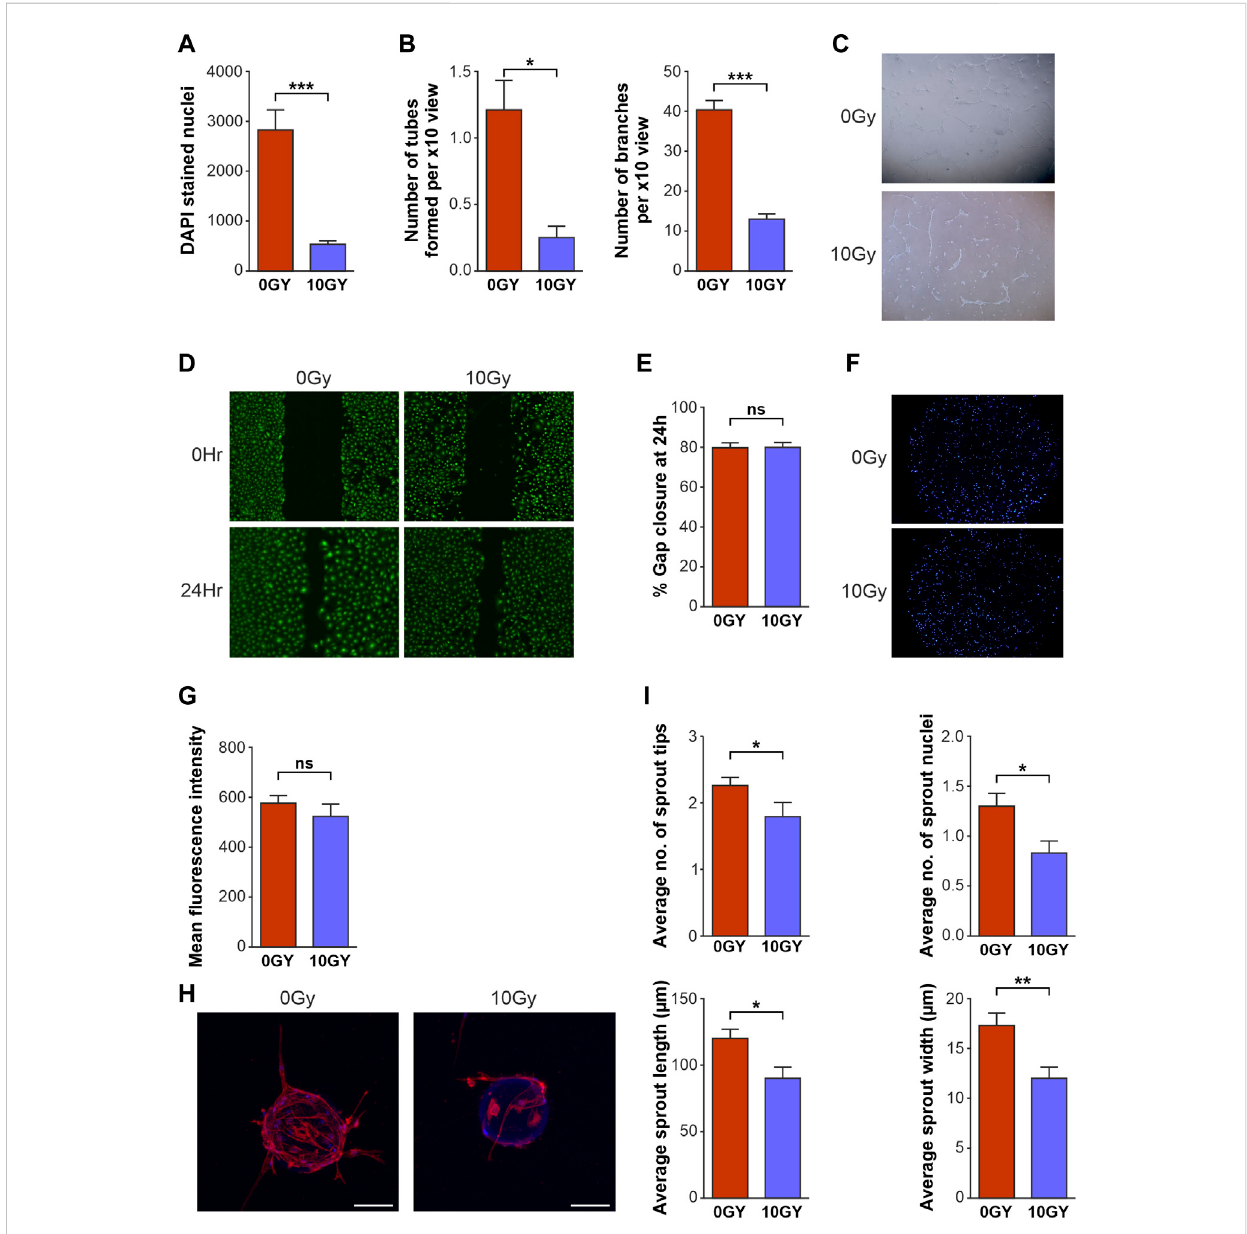
Radiotherapy differentially affects keyfunctional activities of LEC in vitro . Quanti fi cation ofthe effects of10 Gy radiotherapyon LEC (A) proliferation after 48 h, (B) tube formation as assessedbynumberof tubes and branches per x10 objective view at48 h. (C) Bright fi eldimaging ofLEC seeded on GFR Matrigel photographed at 48 h after radiotherapy. 0 Gy control LEC at 48 h x10 objective demonstrating organised and well-formed tubes while 10 Gy irradiated cells display reduced tube formation with disorganised structure. (D) Fluorescence imaging of 2D scratch wound migration assays with representative images of 0Gy and 10 Gy LEC at 0 h and 48 h. (E) Graphical representation of 2D scratch wound migration % gap closure at 24 h. (F) DAPI stained nuclei fl uoresence imaging representing chemotaxis of LEC at 24 h. (G) Graphical representation of chemotaxis at 24 h. (H) Confocal imaging of LEC spheroids photographed 12 days post seeding with x10 objective, where the 0 Gy Non-irradiated spheroid (left) shows an increased number of sprouts with multiple nuclei and increased length and width compared to irradiated (10 Gy) spheroid (right). (I) Spheroid sprouting parameters quanti fi ed at 12 days. All assays performed a minimum of 3 times (with at least 3 technical replicates per assay). Asterisks above bar graphs indicate statistical signi fi cance. Data expressed as mean with error bars representing SEM. p values were calculated using Student ’ s t -test. (* p < 0.05; ** p < 0.01; *** p < 0.0001, ns = not signi fi